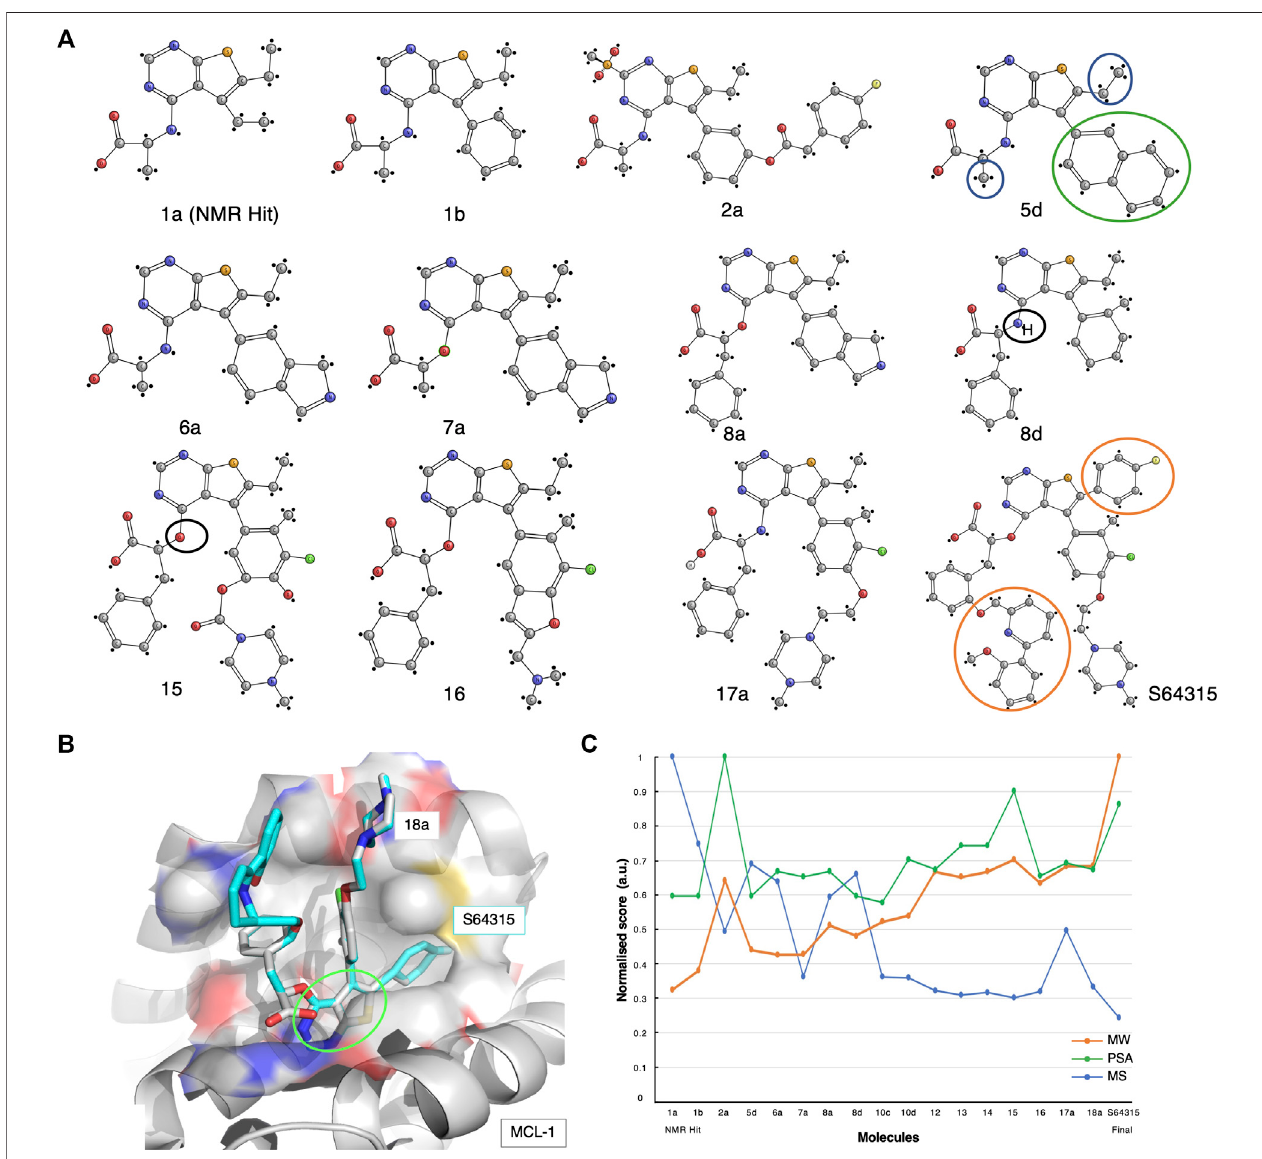
FIGURE 4 | The S64315 case-study. (A) Optimisation pathway: from NMR hits to S64315. All compound nomenclatures are identical to those used in the original manuscript (Szlávik et al., 2019) for an easier comparability. Compound 1a represents the initially identi fi ed thienopyrimidine core by ligand-detected 1D NMR techniques. The green and blue circles for compound 5d highlight the chemical groups that gave rise to crucial NOEs that suggested the initial molecule binding poses (Szlávik et al., 2019). (B) Molecular structure representation of a model of MCL-1 in complex with compound 18a (PDB code: 6QYO). The green ellipse highlights the original thienopyrimidine motif fi rst identi fi ed by an 1D-NMR screening experiment (Szlávik et al., 2019). (C) Molecular similarity, as expressed by the Tanimoto coef fi cient (MS, Blue), normalised molecular weight (MW, orange) and polar surface area (PSA, green) scores for the twelve compounds on the development path